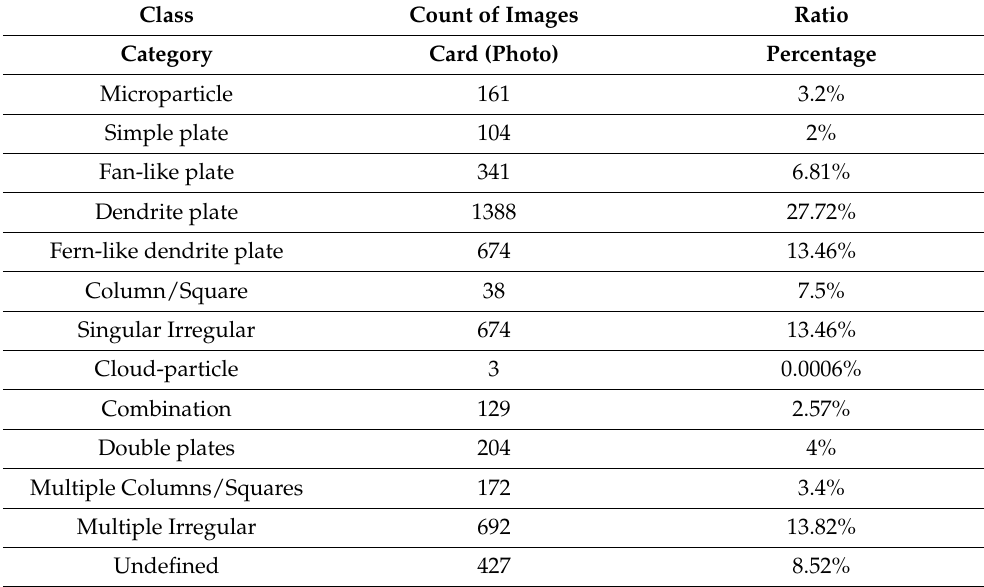
Table 5. The detailed description of the dataset.